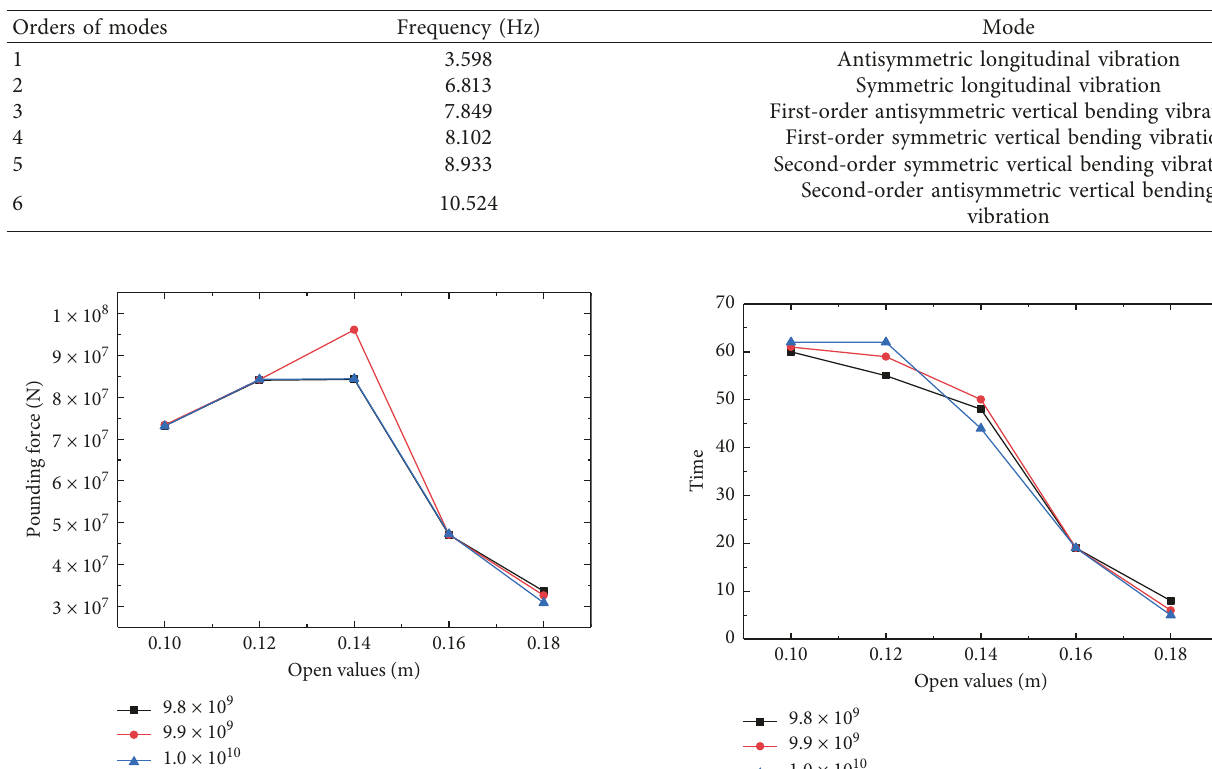
Figure 2: Finite element model. Table 1: Natural frequencies and modes.